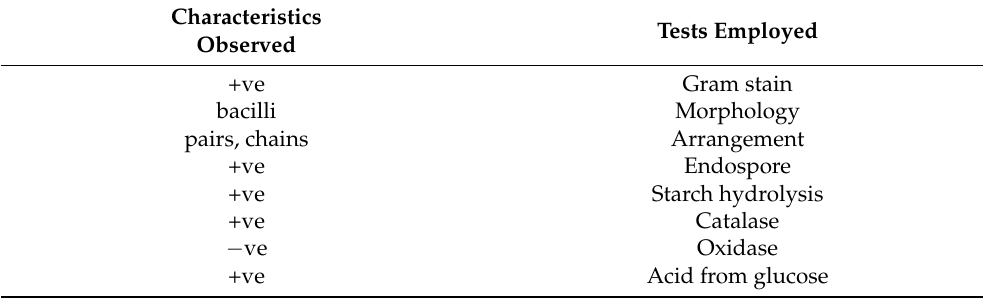
Table 1. Morphological and biochemical characteristics of strain Priestia megaterium PRJNA526404.